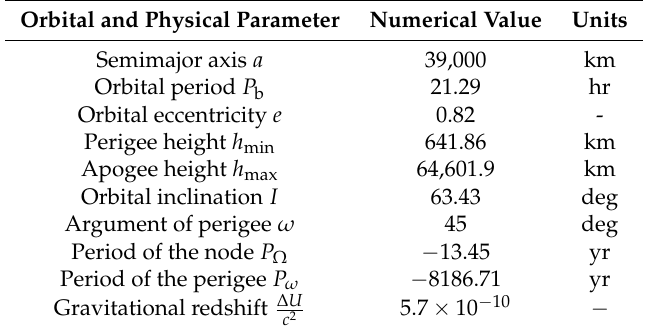
Table A7. Nominal pN (first four rows from the top) and mismodeled Newtonian (first seven rows from the bottom) rates of change, averaged over one orbital revolution, of the semimajor axis a , the eccentricity e , the inclination I , the longitude of the ascending node Ω , the argument of pericenter ω , and the mean anomaly at epoch η for the ideal (no orbital injection error on I assumed) orbital configuration of Table A6. The units are cm yr − 1 for (cid:104) ˙ a (cid:105) , and mas yr − 1 for (cid:104) ˙ e (cid:105) , The uncertainties in the classical rates of change due to the geopotential are the formal, statistical errors σ J in J (cid:96) , (cid:96) = 2, 3, . . . 8 of the model Tongji-Grace02s [48] quoted in (cid:96)